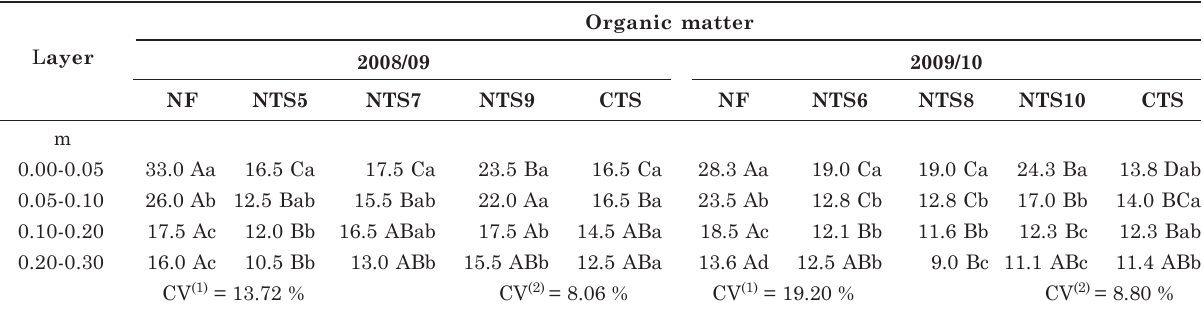
(1) Coefficient of variation of treatments (plots) and (2) coefficient of variation for layers (split-plots). 2008/09 growing season: NF: native forest; NTS5: five-year no-tillage system; NTS7: seven-year no-tillage system; NTS9: nine-year no-tillage system; and CTS: conventional tillage system. 2009/10 growing season: NF: native forest; NTS6: six-year no-tillage system; NTS8: eight-year no-tillage system; NTS10: ten-year no-tillage system; and CTS: conventional tillage system in a Red Oxisol. Mean values followed by the same letter do not differ from each other by the Tukey test (p<0.05). Upper-case letters indicate the comparison of soil properties in the same layer, and lower-case letters compare mean values of layers of the same soil